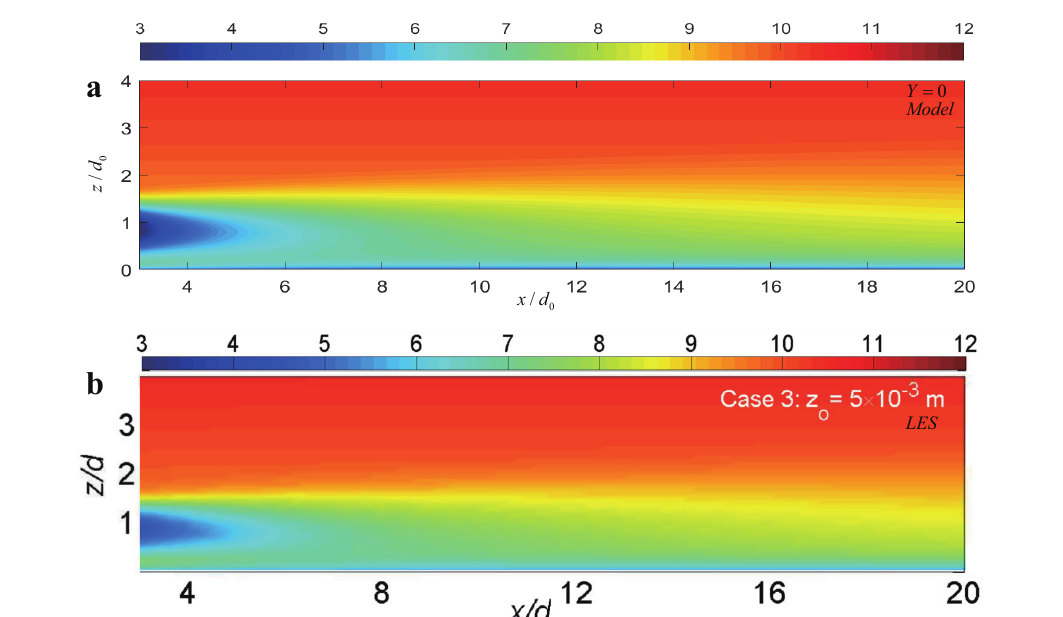
Figure 13. X – Z views of the streamwise velocity at Y = 0 estimated by ( a ) the model and ( b ) LES (reproduced with permission from Wu and Porté-Agel